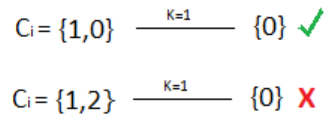
Figure 5: Instance and neighbours kept in the dataset. The classes are { 0 , 1 , 2 } , where the class “2” is the majority.